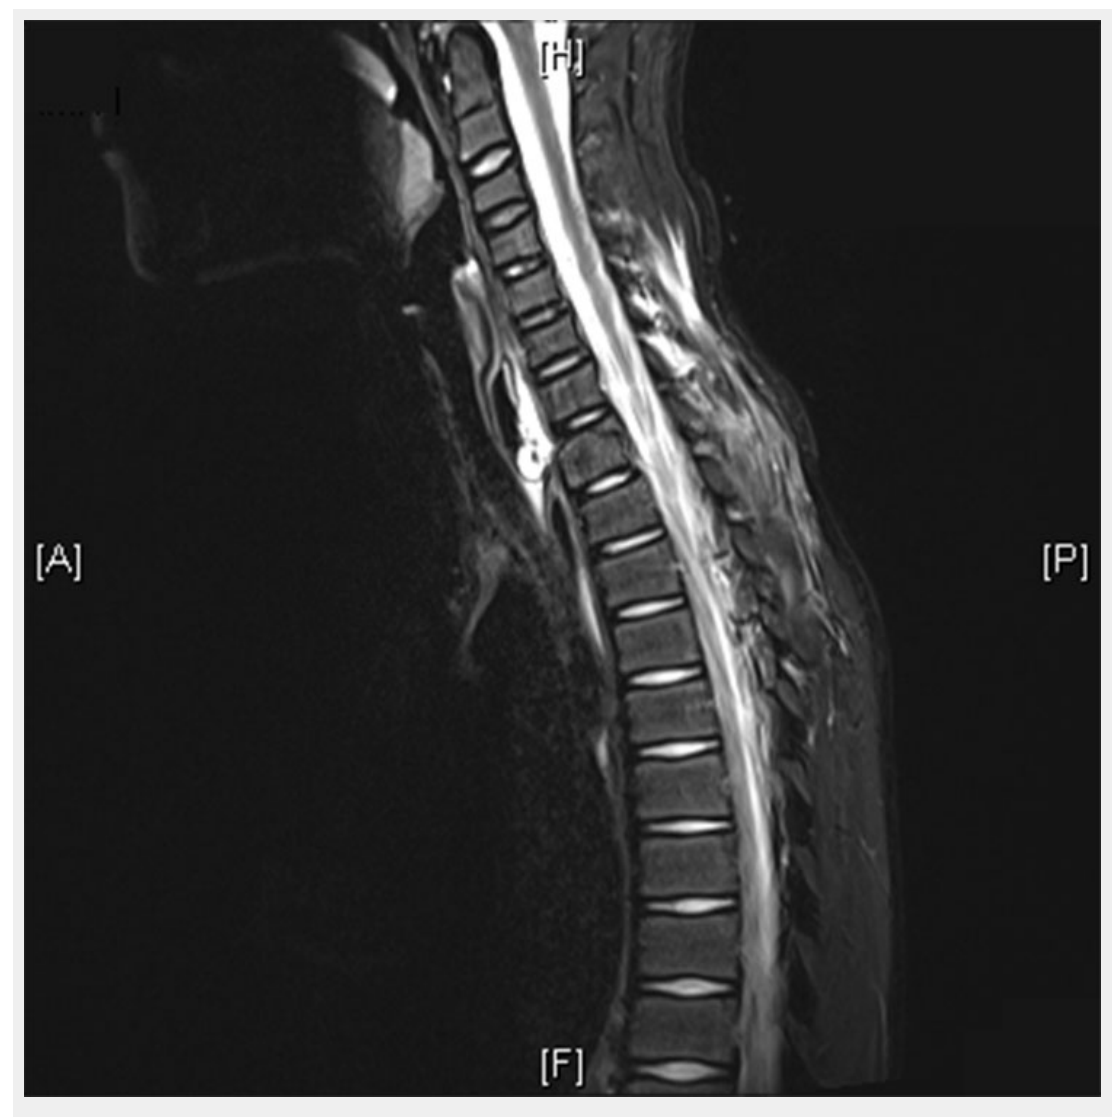
Figure 4 ( C ). 3 months in a halo followed by 4 weeks in a supportive collar led to full